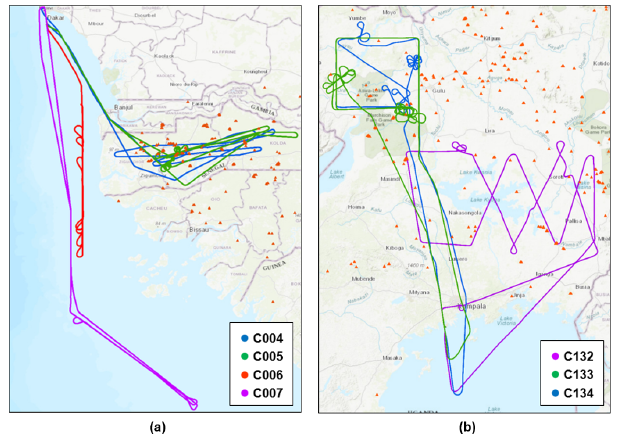
Figure 1. FAAM ARA flight tracks of (a) MOYA-I biomass burning sampling flights C004 (blue), C005 (green), C006 (red), and C007 (purple) over the south-western region of Senegal and the Atlantic seaboard and (b) MOYA-II biomass burning sampling flights C132 (purple), C133 (green), and C134 (blue) over northern Uganda. MODIS infrared satellite retrievals of fires present between (a) 28 February and 2 March 2017 and (b) 28 and 29 January 2019 are also shown (orange triangles). © OpenStreetMap contributors and the GIS user community 2020. Distributed under a Creative Commons BY-SA License.